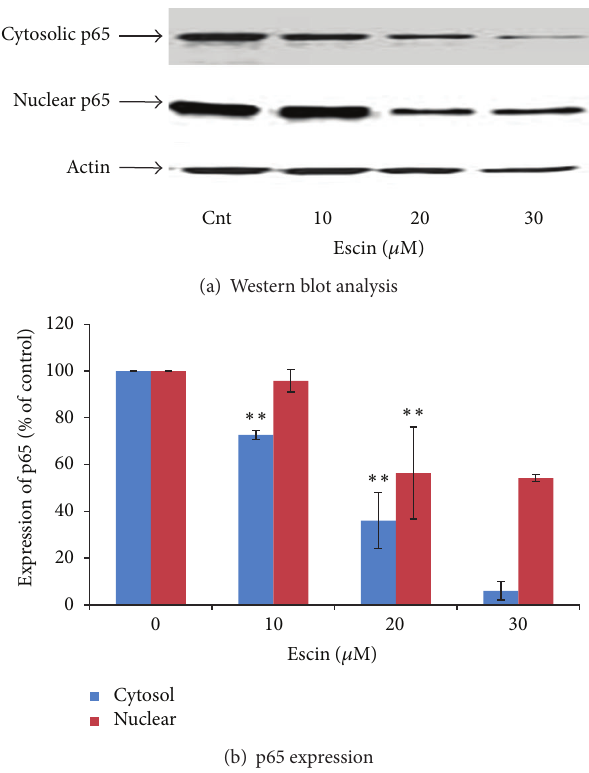
Figure 3: Effect of Escin on the expression of p65 in the cytosol and nucleus of Panc-1 cells. (a) Western blot analysis. (b) Densitometry results averaged from 3 independent experiments. ∗∗ 𝑃 < 0.01 versus